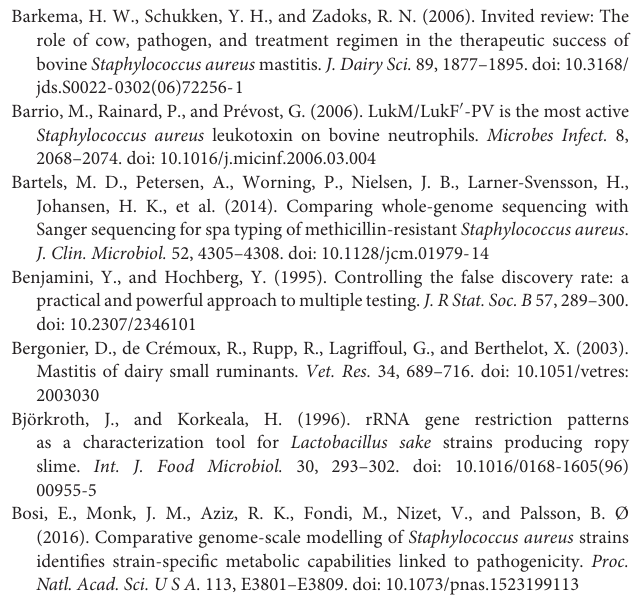
Supplementary Figure 1 | Pangenome characterization based on distribution of functional categories. Distribution of pangenome into functional categories obtained after comparing the pangenome with the Clusters of Orthologous Groups (COG) reference database. The average amount of proteins in each COG category is shown for the peracute group of Staphylococcus aureus isolates (red bars) and control group of S. aureus isolates (gray bars). Standard deviation between isolates is indicated in each